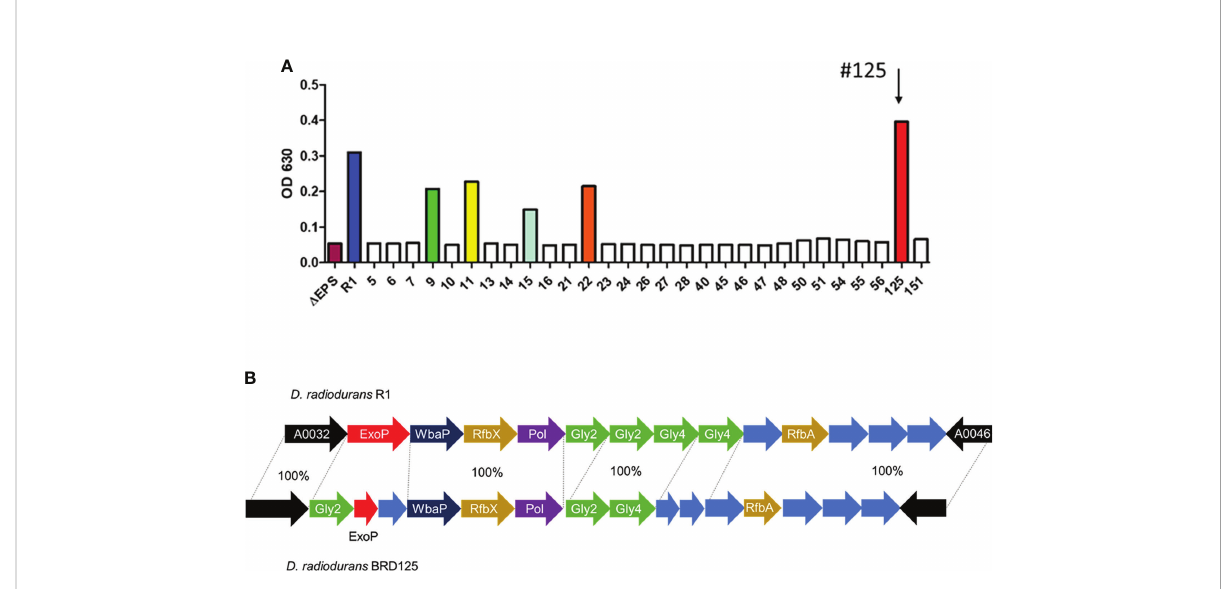
regulatory protein, Gly: Glycosyltransferase, WbaP: undecaprenyl-phosphate galactose phosphotransferase, RfbX: polysaccharide transporter, RfbA: glucose-1-phosphate thymidyltransferase. Blue arrow: hypothetical